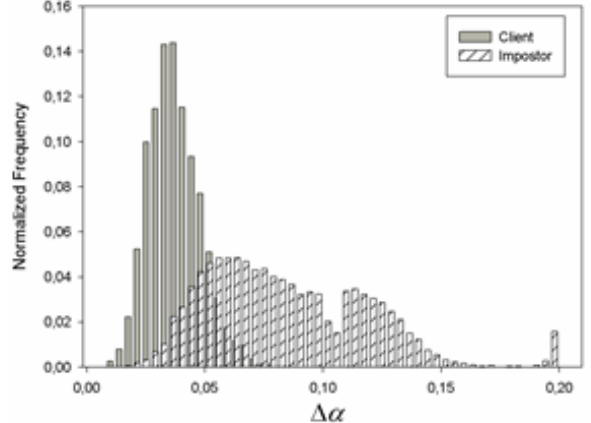
Figure 2. The Histogram for ! " using VTLN.